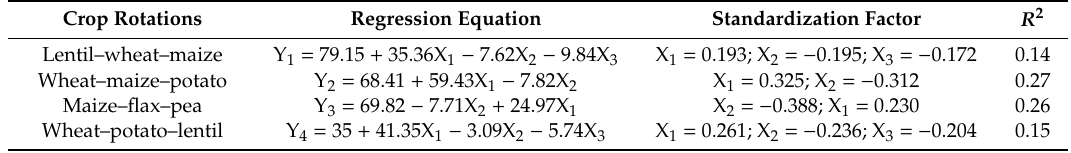
Table 3. Regression analysis of soil physical and chemical factors among crop rotations.